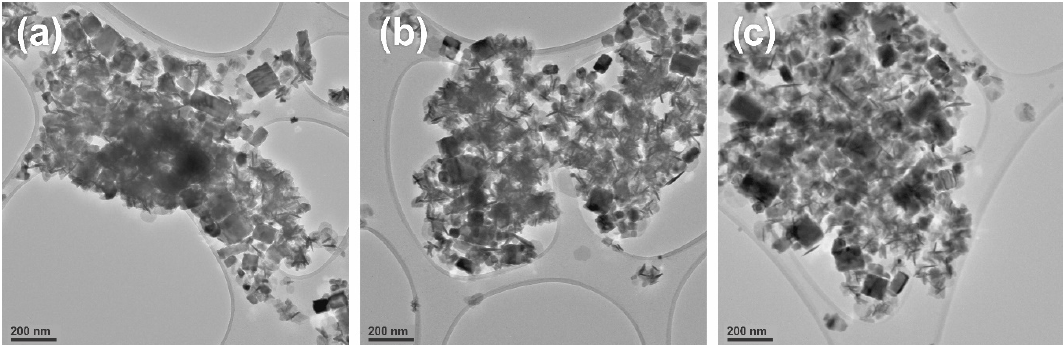
Figure 4. TEM images of as-deposited PbS at: ( a ) 400 °C; ( b ) 450 °C; ( c ) 500 °C.